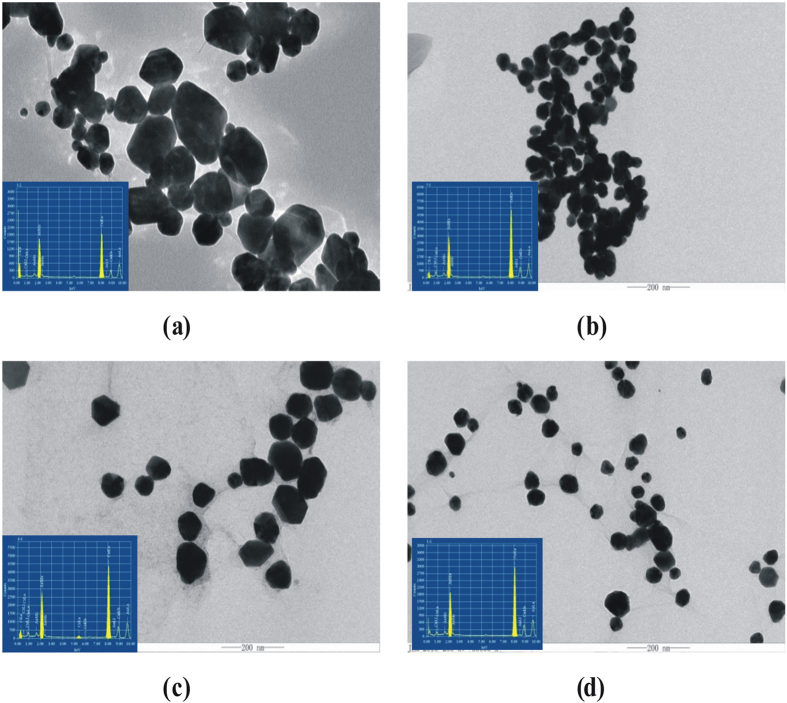
TEM and EDS of AuNPs.(a) 0.1 mmoL/L L-CyS + 0.5 mL 1% HAuCl4, 50 °C for 5 min; (b) a + 0.58 μg/mL AuNPc; (c) a + 1.9 μmoL/L AgNPs; (d) a + 0.5 mL 0.02% GO.